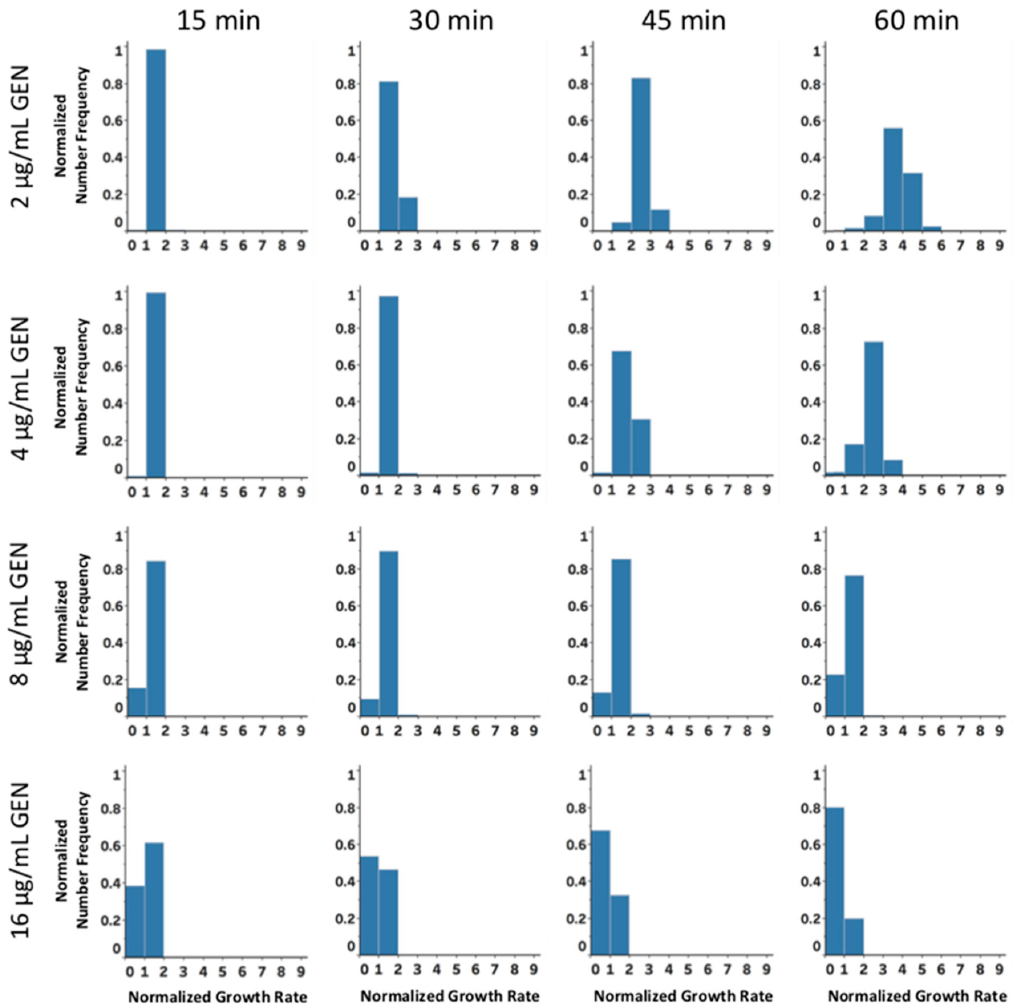
Figure 2. Number-based distribution of normalized single-cell growth rate for several thousand E. cloacae cells treated with 2, 4, 8 and 16 µg/mL of gentamicin.